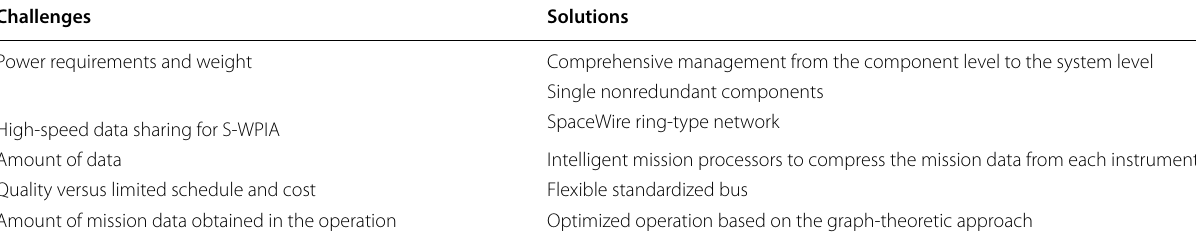
Table 6 Summary of the challenges associated with attaining an appropriate balance between the mission requirements and the limited resources of the small satellite and the steps taken to address